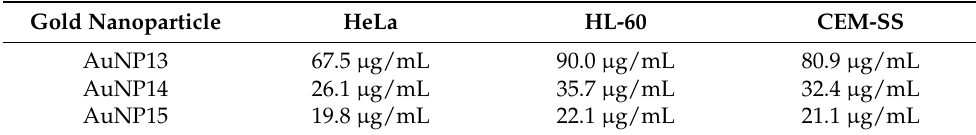
Figure 4. Dose-response curves of ( a ) HeLa, ( b ) HL-60, and ( c ) CEM-SS after 72 h incubation in AuNP. Data obtained from MTT assay normalized to control (untreated) cells. Table 3. Half maximal inhibitory concentration (IC50) for the studied cell lines.